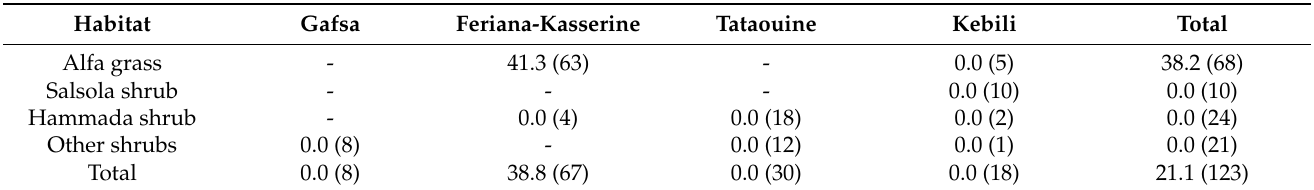
Table 1. Percentages of song broadcasting trials with positive response by Dupont’s larks in different regions and habitat types. Number of trials in brackets.